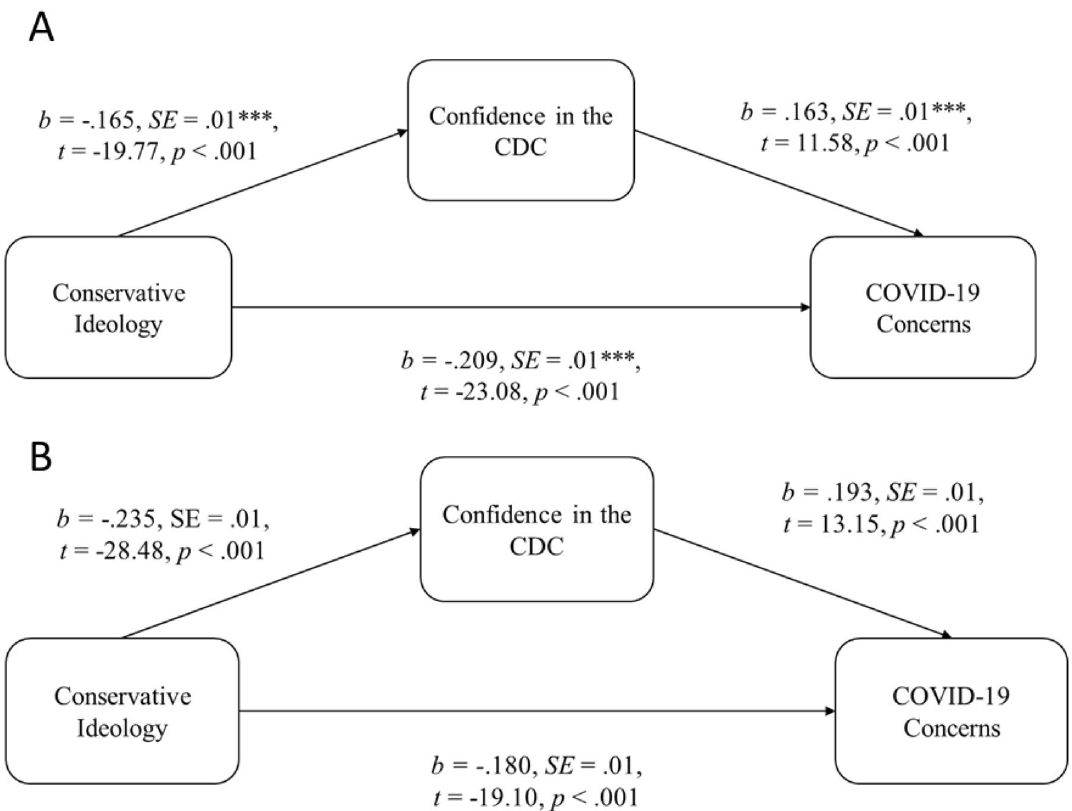
Figure 1. ( A , B ) Indirect effect test ( proc calis , SAS 9.4, Path Model with weighted coefficients, Maximum Likelihood testing method) of conservative ideology on concerns about COVID-19 via the mechanism of trust in science, controlling for binarized gender (male = 1, female = − 1), education level, income level, and age, in Study 1a ( A , top) and Study 1b ( B , bottom). Figure was constructed in Microsoft PowerPoint with manually input data copied from SAS 9.4 output. Note: *** p <